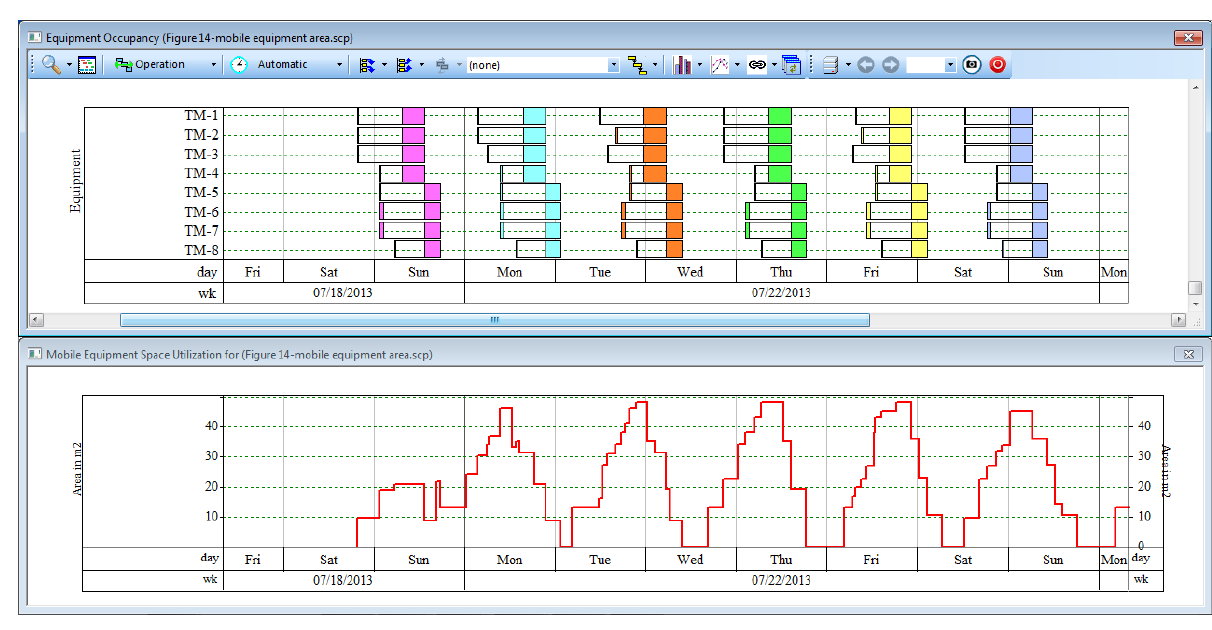
Figure 15. Mobile equipment floor space